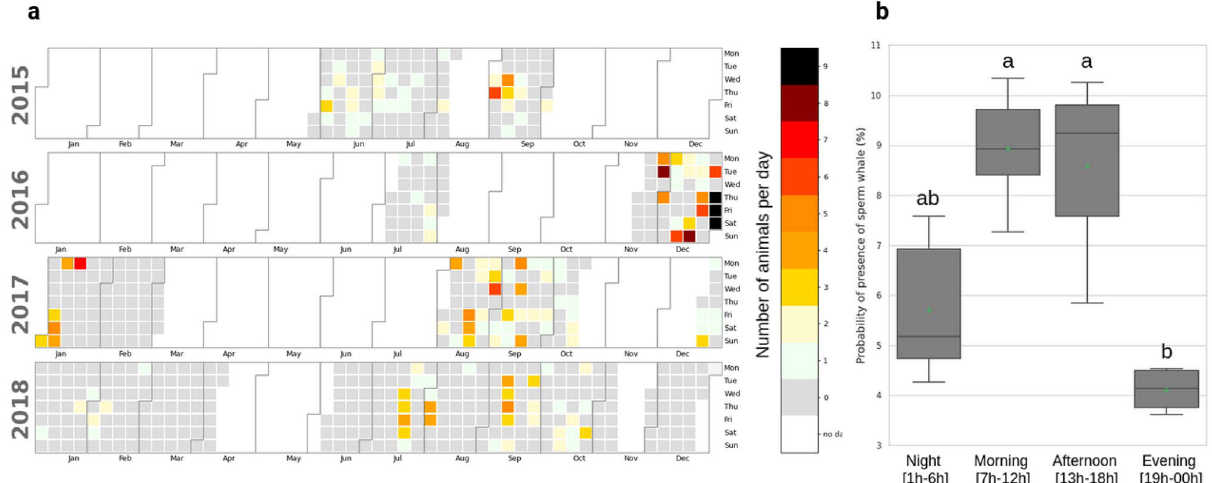
Figure 1. Left ( a ): the Number of detected sperm whales per day during the 4 years of recordings (white region: no d = no data ). Right ( b ): mean probability of presence for each period of the